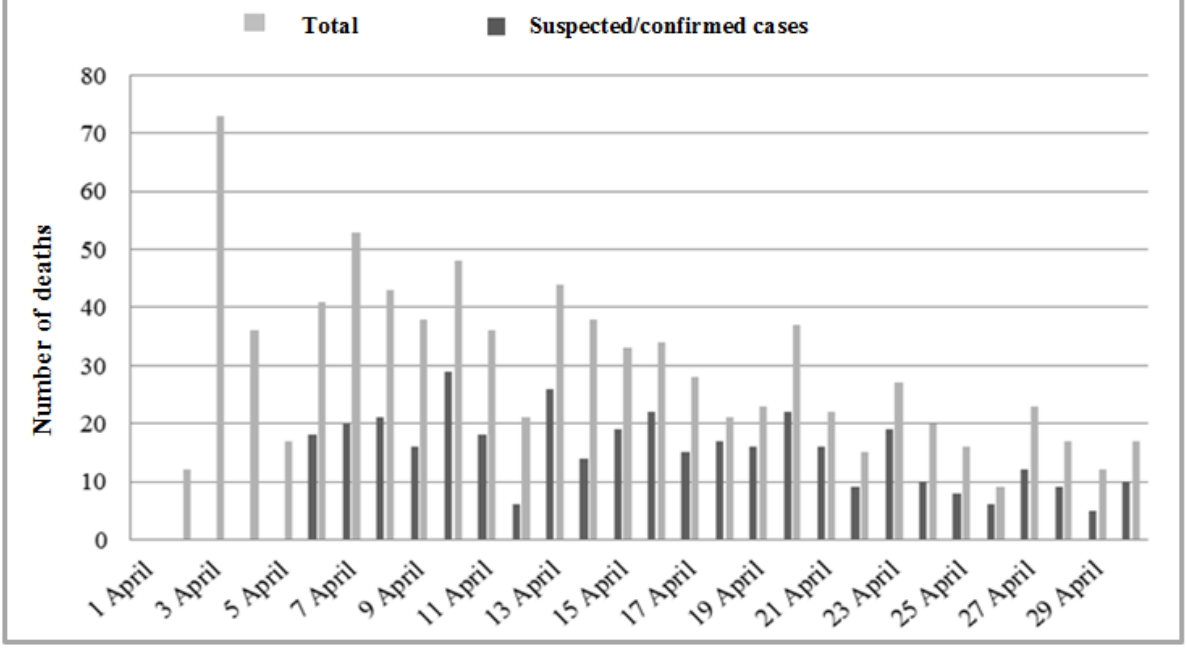
Figure 3. Total number of deaths and deaths in suspected/confirmed cases among residents, as reported by LTCF health care staff over 30 days.